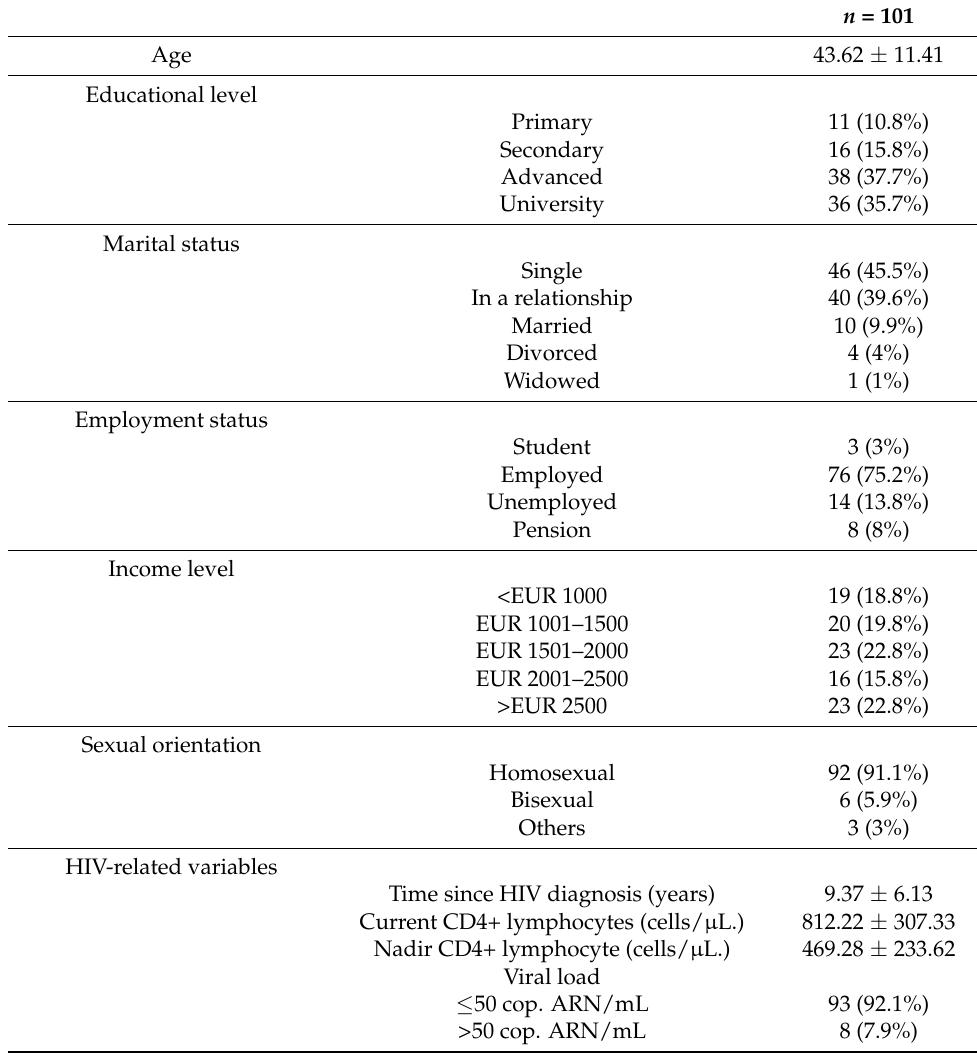
Table 1. Sociodemographic and serological status of the